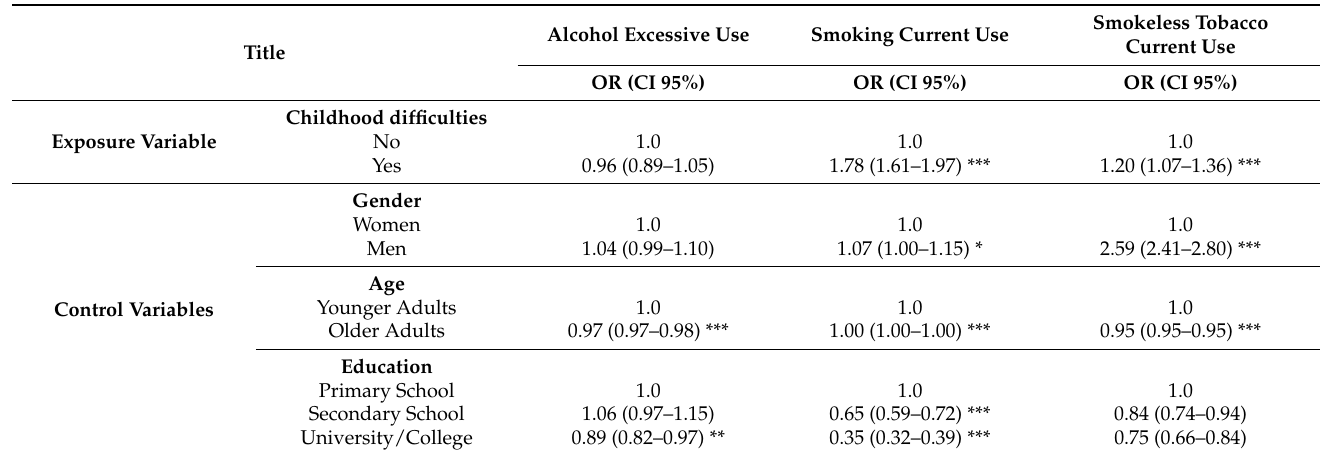
Table 4. Adjusted odds ratio (OR) and 95% confidence interval (CI) for substance use in relation to self-perceived childhood